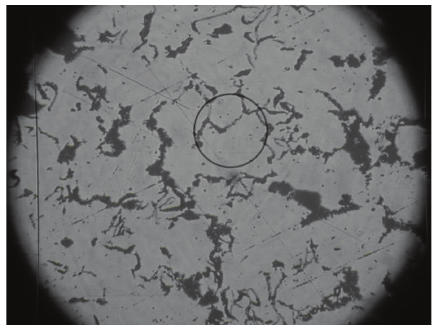
Figure 6: Microstructure in zone F 500x.